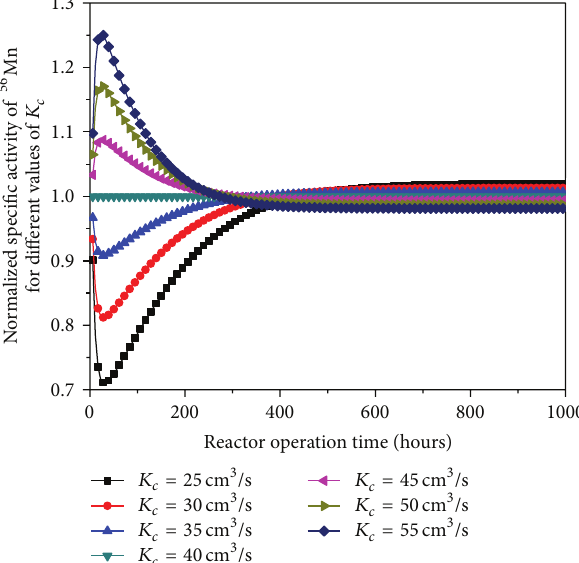
Figure 4: Normalized specific activity of 56 Mn as a function of 𝐾 𝑐